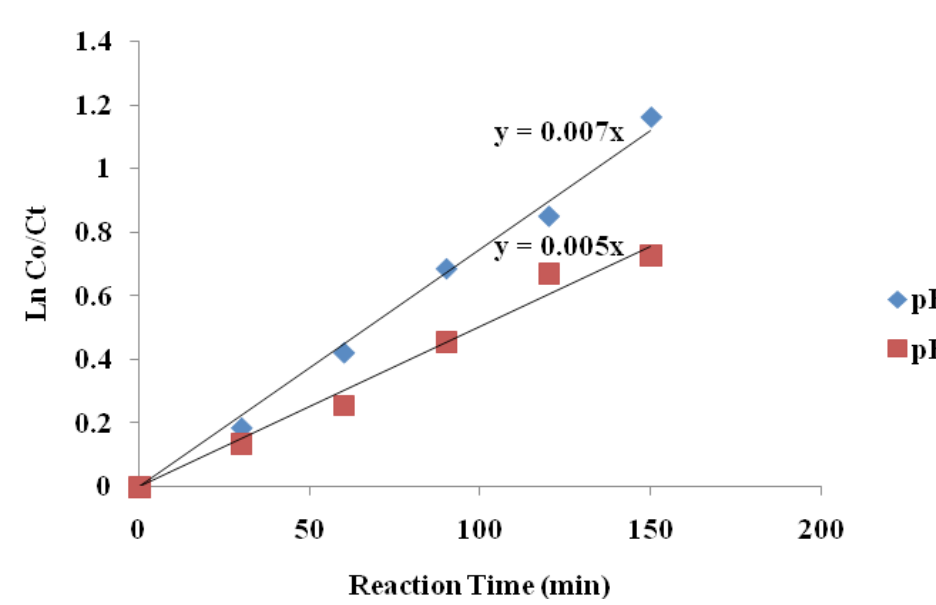
Fig. 8. Plot of Ln (C /C ) versus time for the degradation of methyl orange: effect of initial pH solution. 0 t